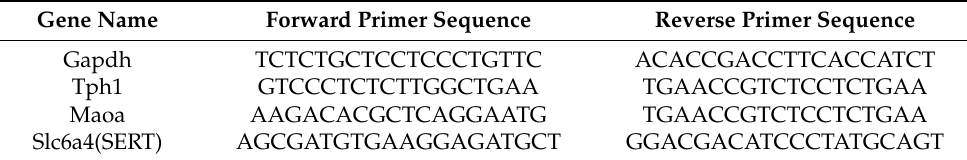
Table 1. Primers used for the detection of RIN-14B for RT-PCR reactions.